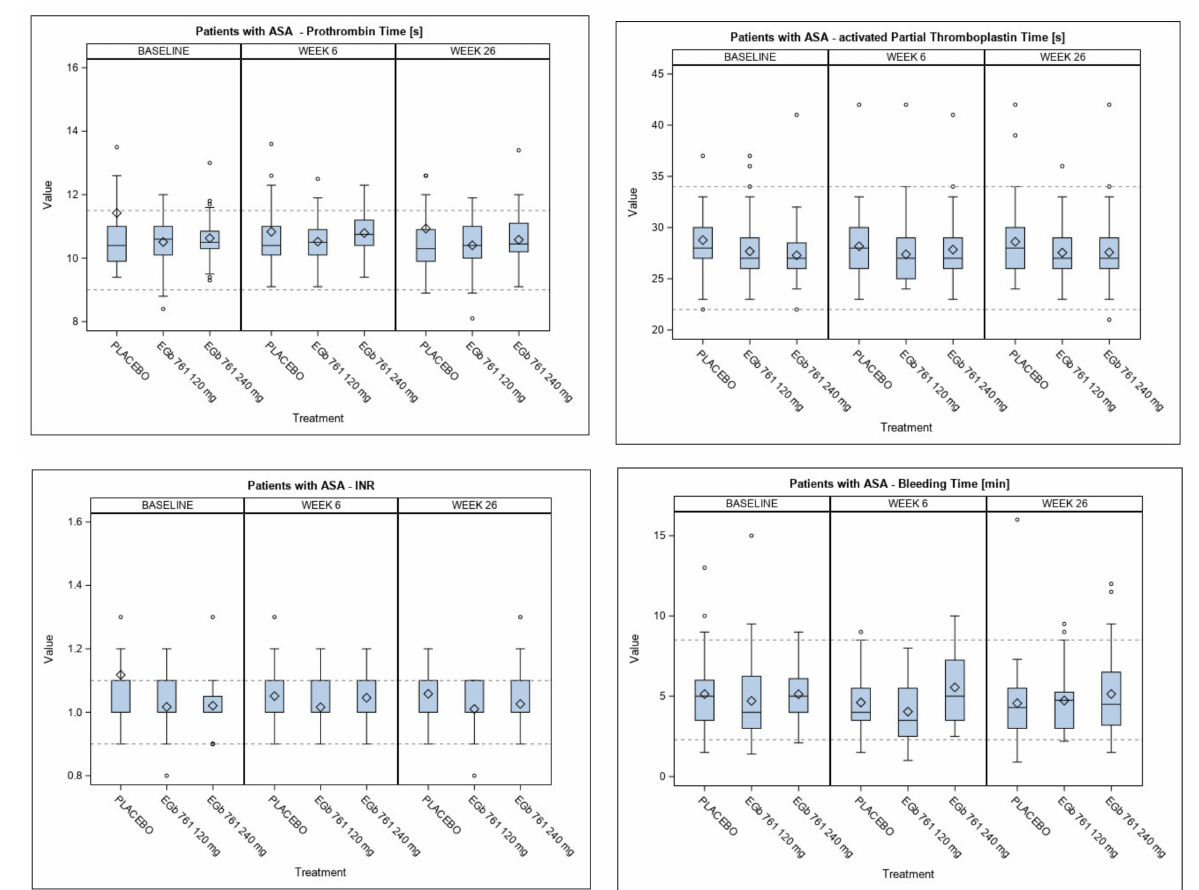
Figure 2. Blood coagulation (prothrombin time [reference range of 9–11.5 s], activated partial thromboplastin time [reference range of 22–34 s], international normalized ratio (INR) [reference range of 0.9–1.1]) and bleeding time [reference range of 2.3–8.5 min]) in subjects taking acetylsalicylic acid (ASA) as a concomitant medication at baseline, 6 weeks and 26 weeks (endpoint). (In the placebo group, two subjects who took acetylsalicylic acid and warfarin had values of PT, APPT and INR higher than 16 s, 50 s and 1.6, which are not displayed. These values were included in the calculation of the characteristics of the empirical distributions shown in the box plots.). Box-and-whiskers plots showing the mean (diamond), median (line within the box), interquartile range [IQR] (box), range within 1.5xIQR (whiskers), values without 1.5xIQR (circles). All p -values for pairwise comparisons between the active treatment groups and placebo at week 26 are not